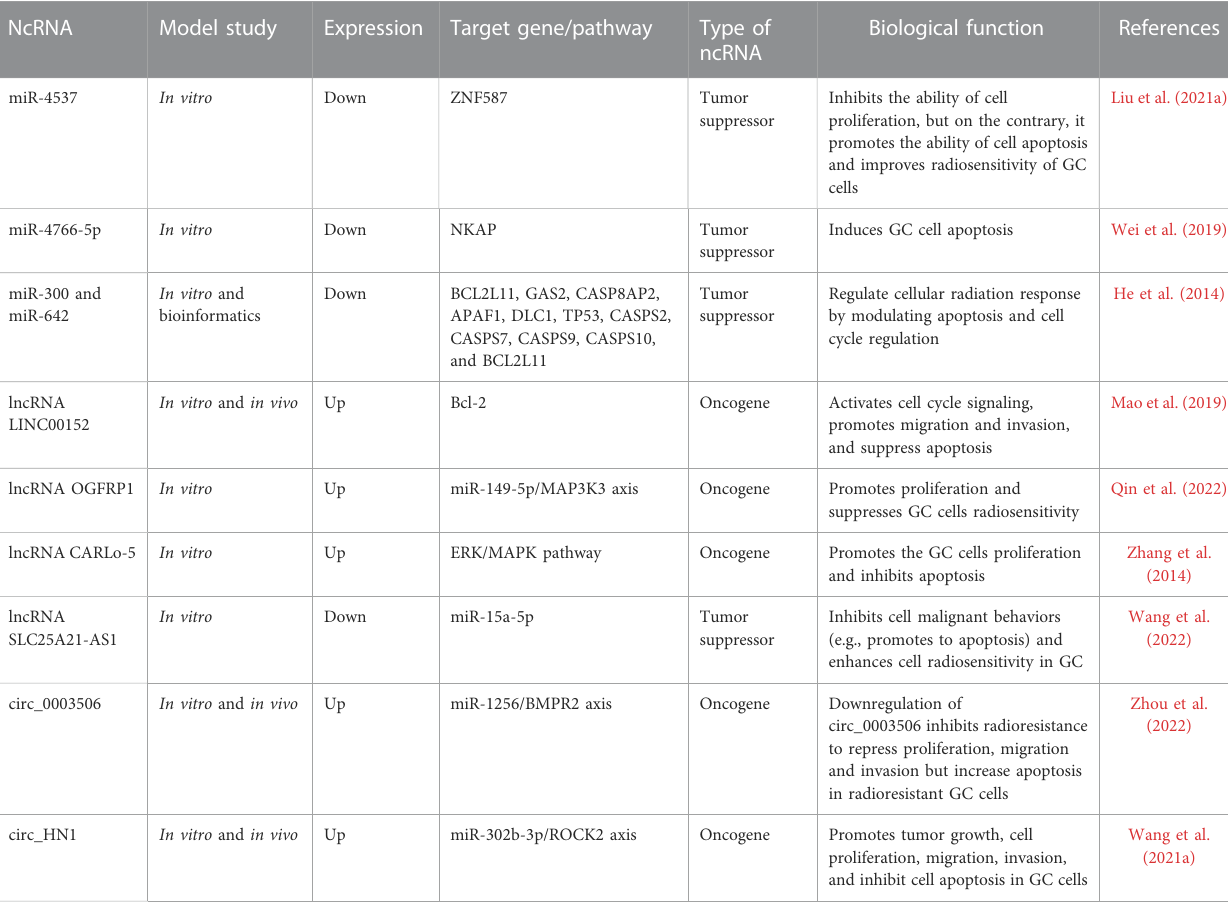
TABLE 3 Some non-coding RNAs (ncRNAs) that regulate stability to apoptosis in gastric cancer (GC) cells under the in fl uence of